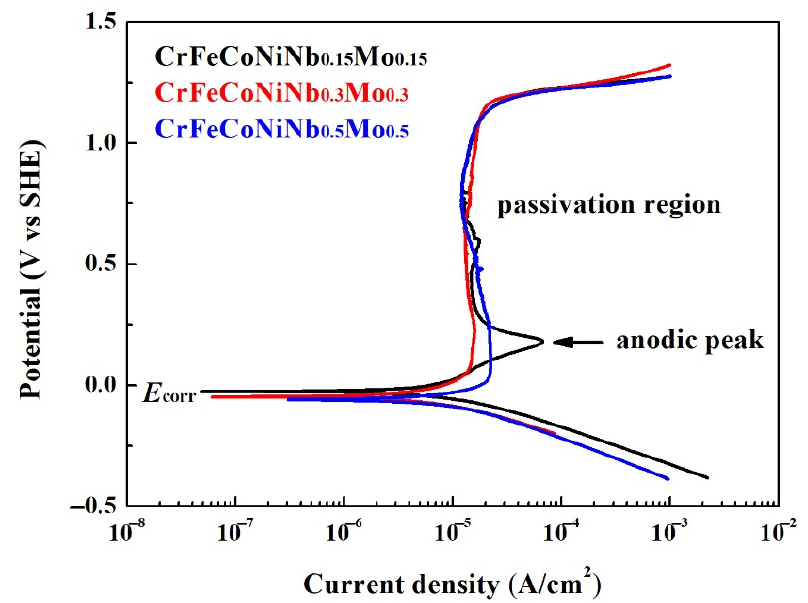
Figure 4. Potentiodynamic polarization curves of as-cast CrFeCoNiNb x Mo x alloys tested in the 1 M deaerated sulfuric acid solution at 30 ° C. Table 4. Standard electrode potential at 25 ◦ C [25]. Table 3. Potentiodynamic polarization data of the as-cast CrFeCoNiNb x Mo x alloys in 1M deaerated H 2 SO 4 solution at 30 ° C.